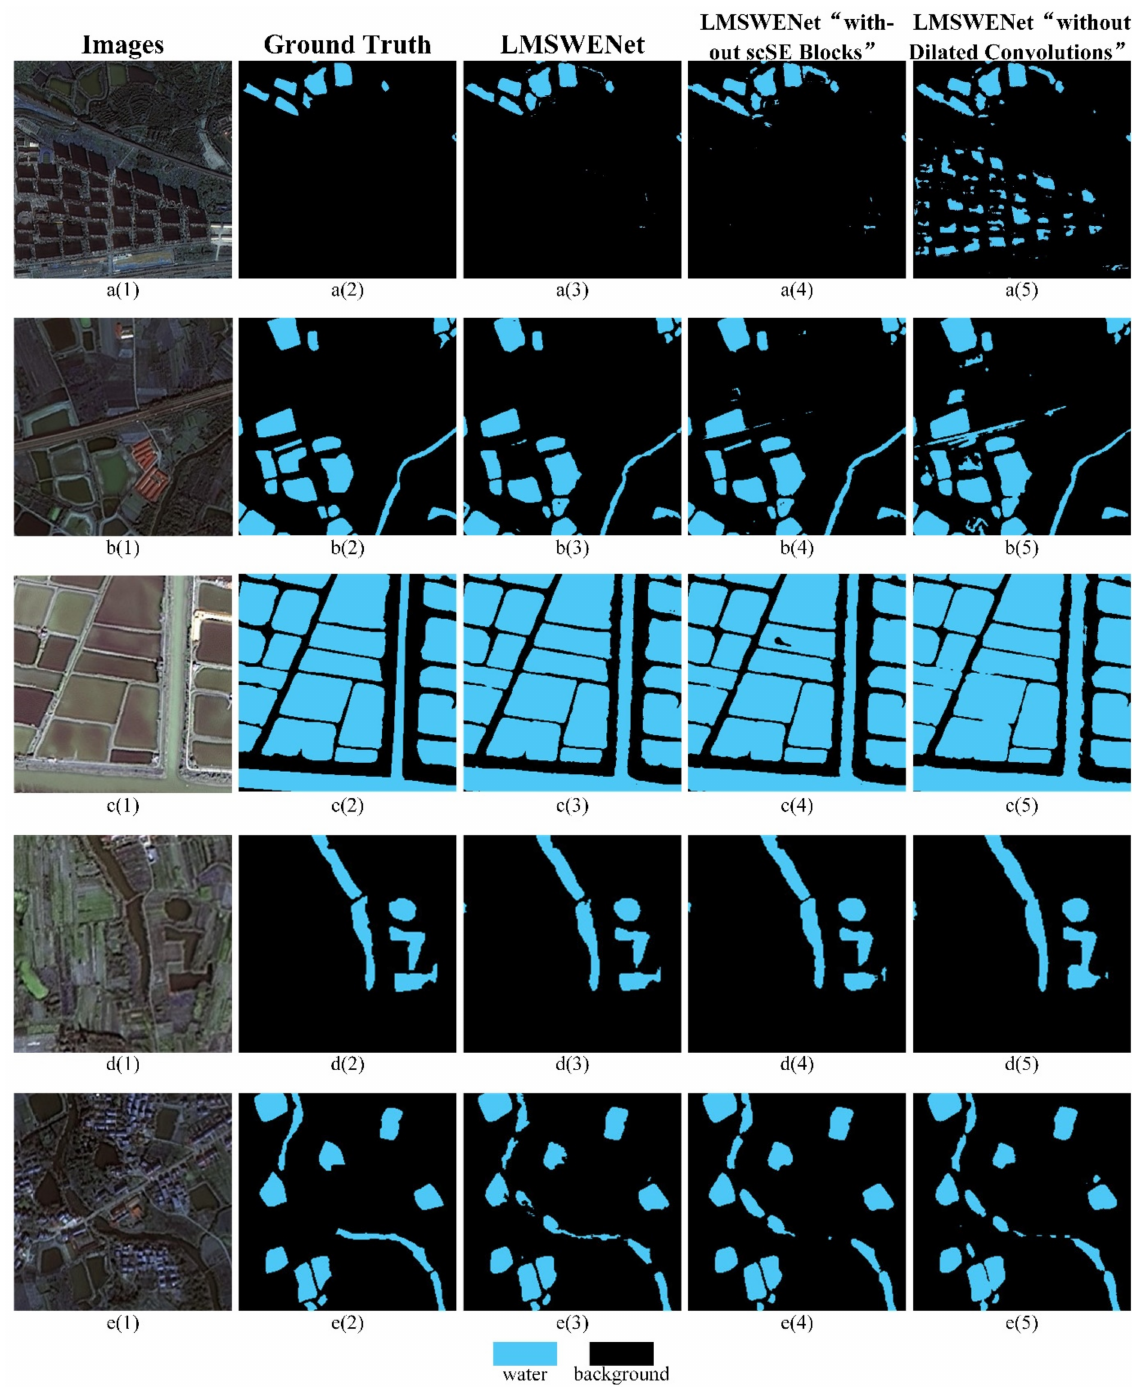
Figure 11. Land surface water information extraction results for LMSWENet, LMSWENet “without scSE Blocks”, and LMSWENet “without Dilated Convolutions”. ( a ( 1 )) is the raw image of architecture shadows, and ( a ( 2 – 5 )) are the water areas extracted from ( a ( 1 )) using manually labeling, LMSWENet, LMSWENet “without scSE Blocks”, and LMSWENet “without Dilated Convolutions”, respectively; ( b ( 1 )– e ( 7 )) are the water areas extracted from geography scenes with highways, ponds, small puddles, and rivers,